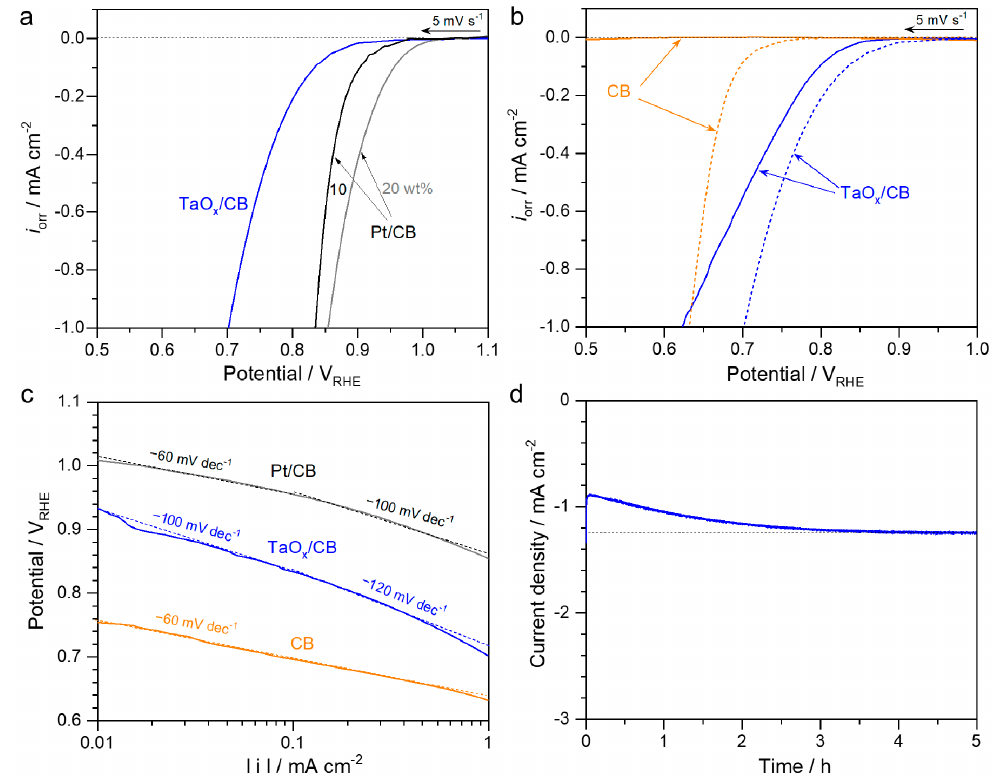
Figure 4. ORR activity of ultrafine TaO x /CB nanoparticles ( a ) LSV of the ultrafine TaO x /CB nanopar- ticles prepared by electrodeposition and subsequent annealing treatment in an H 2 flow for ORR in O 2 -purged 0.1 M KOH aqueous solution at a rotation rate of 1600 rpm. For comparison, commercial 10 and 20 wt% Pt/CB catalysts were also measured in the same manner. ( b ) The LSVs of the prepared TaO x /CB and bare CB nanoparticles for ORR in O 2 -purged 0.1 M KOH (dotted lines) and 0.1 M H 2 SO 4 aqueous solutions (solid lines). ( c ) Tafel plots for TaO x /CB, bare CB, and commercial 20 wt% Pt/CB catalysts, determined from the LSVs measured in O 2 -saturated 0.1 M KOH aqueous